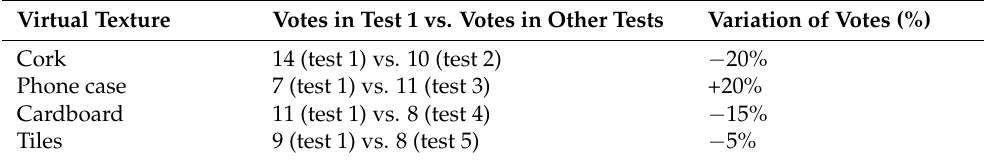
Table 3. Comparison of volunteers’ votes between test 1 and the remaining